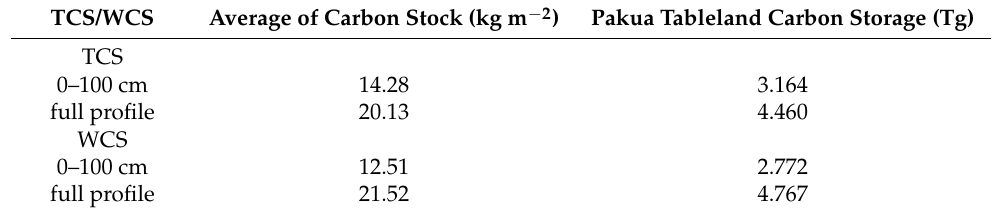
Table 3. Comparison of different calculation methods for the Pakua tableland carbon